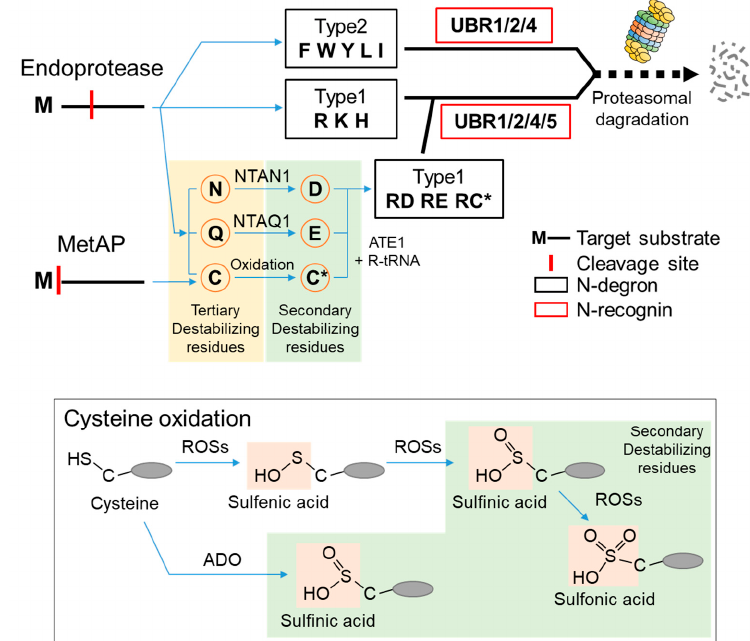
Figure 1. The classical Arg/N-degron pathway. N-degrons are classified as type 1 or type 2 accord- ing to the residues exposed by proteases such as Endoprotease and MetAP. Asn, Gln, and Cys are tertiary destabilizing residues (in the light-yellow box), converted into secondary destabilizing res- idues, Asp, Glu, and oxidized-Cys (in the light-green boxes), respectively, and finally become type 1 Arg N-degrons through ATE1-mediated arginylation (C* denotes the oxidized N-terminal cyste- ine residue). Cysteine is oxidized by typical ROSs and the recently reported ADO (ROSs, reactive oxygen species; ADO, cysteamine (2-aminoethanethiol) dioxygenase ) .